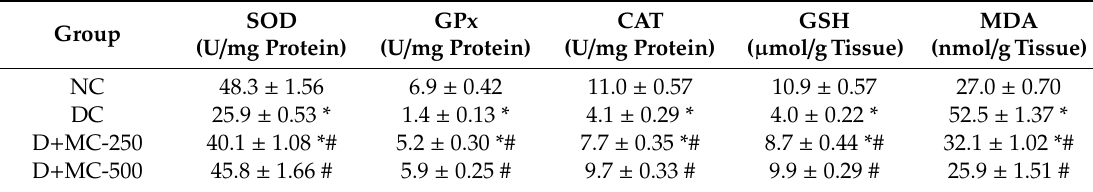
Table 2. E ff ect of MC on antioxidant profile: superoxide dismutase (SOD), glutathione peroxide (GPx), catalase (CAT), glutathione (GSH), and malondialdehyde (MDA) in testicular homogenate of STZ-induced diabetic male rats. SOD Group (U / mg